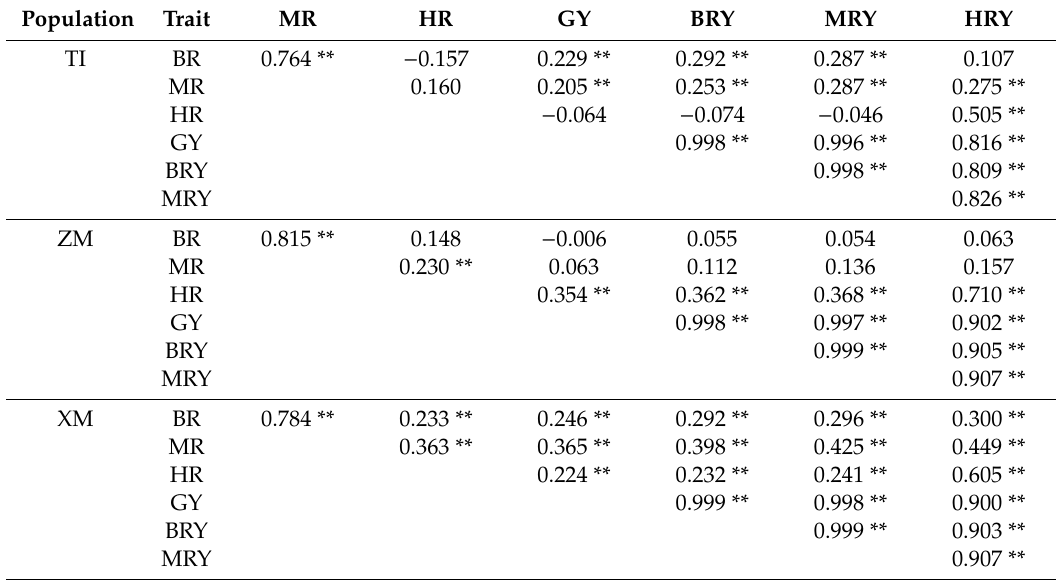
Table 1. Simple correlation coe ffi cients between seven traits in three RIL populations of rice.